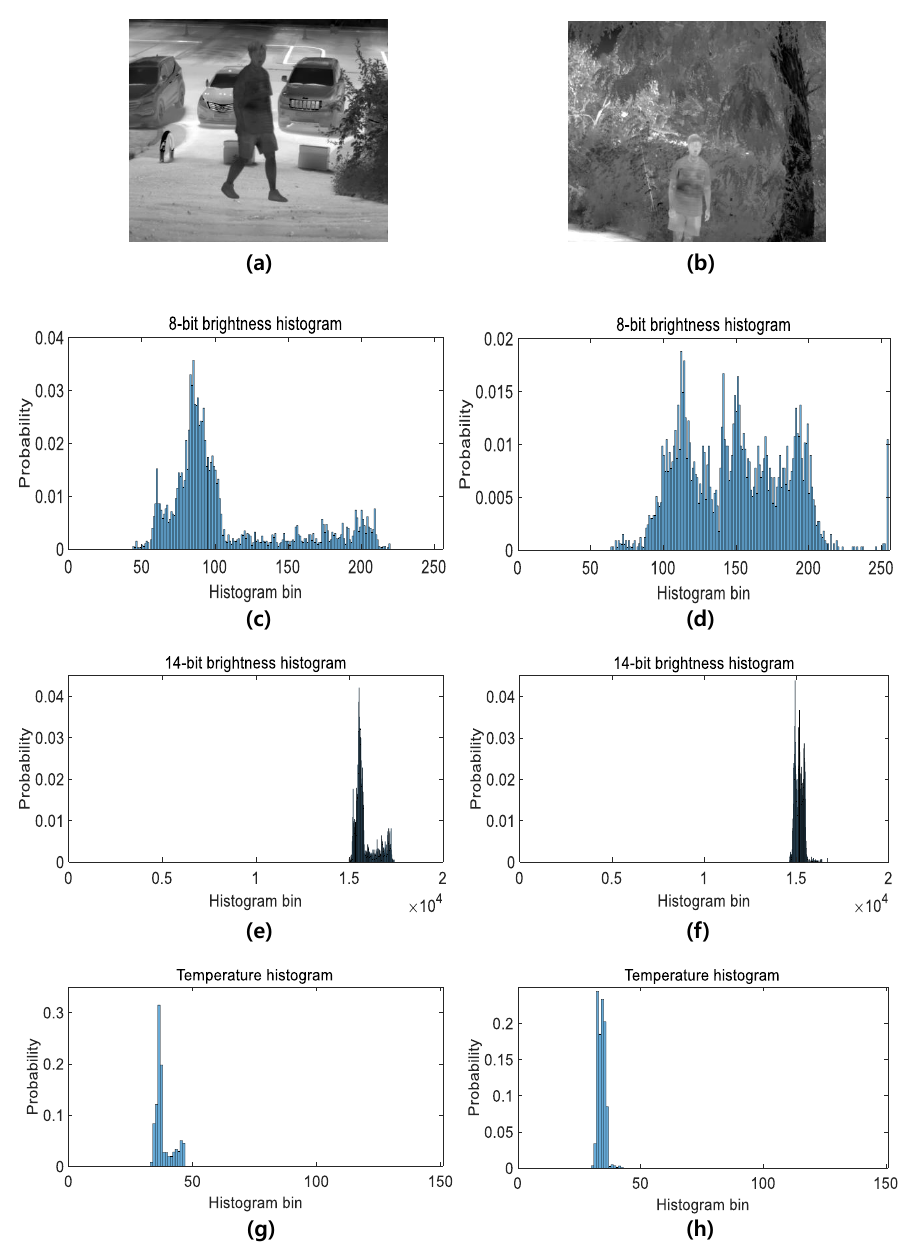
Figure 8. Comparison of the eight-bit brightness, 14-bit DC and temperature histogram when the background temperature changes: ( a ) target of high temperature blackbody (BB); ( b ) target of low temperature BB; ( c , d ) brightness histogram of ( a , b ); ( e , f ) 14-bit DC histogram of ( a , b ); ( g , h ) temperature histogram of ( a , b